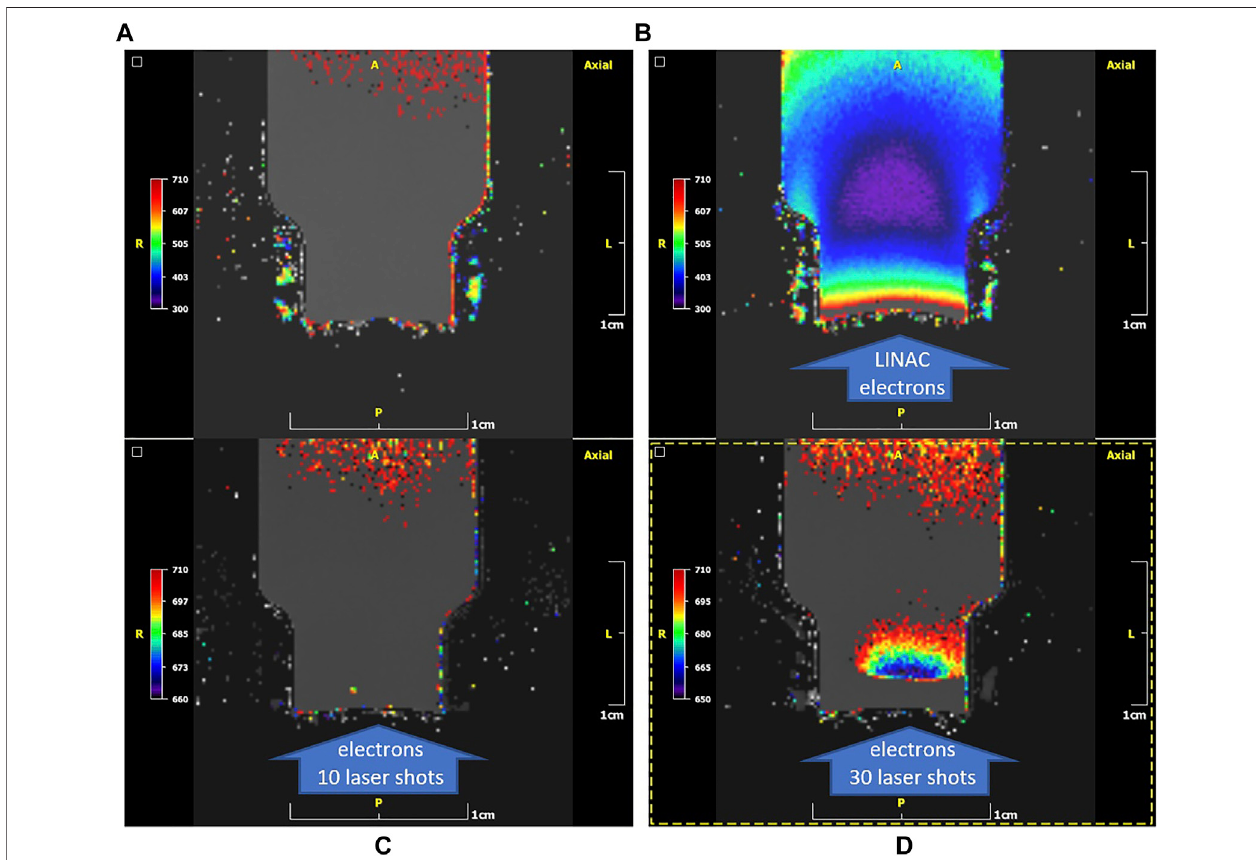
FIGURE 9 | T2 colour parametric maps (NIH palette) ofthe gel-vials. (A) : case ofa non-irradiated vial. T2 ofnon-irradiated gel (mostly grey areas): 760 ± 5 ms. (B) : case ofanirradiated vialonaclinicalLINAC.Thedirectionofirradiationisshownbythearrow. T2oftheirradiated gel(purple areas):325±5 ms.Note thehighT2values (orange/red) close to the cap area with the thin plastic barrier (bottom of the image) presumably due to oxygen penetration from outside along with suppression of the doseresponse. (C) :caseofanirradiatedvialon45 TWlasersourcewith10shots.T2oftheirradiatedgel(mostlygreyareas):750±5 ms.Nopolymerizationcanbe observedintheentranceregion(arrow). (D) :caseofanirradiatedvialonthe45 TWZEUSlasersourcewith30shots.MinimumT2oftheirradiatedgel(blueareas):657± 5 ms. Maximum T2 of irradiated gel (mostly grey areas): 754 ± 4 ms. Note the suppression of polymerization in the entrance region (arrow) indicated by the grey level encoding of